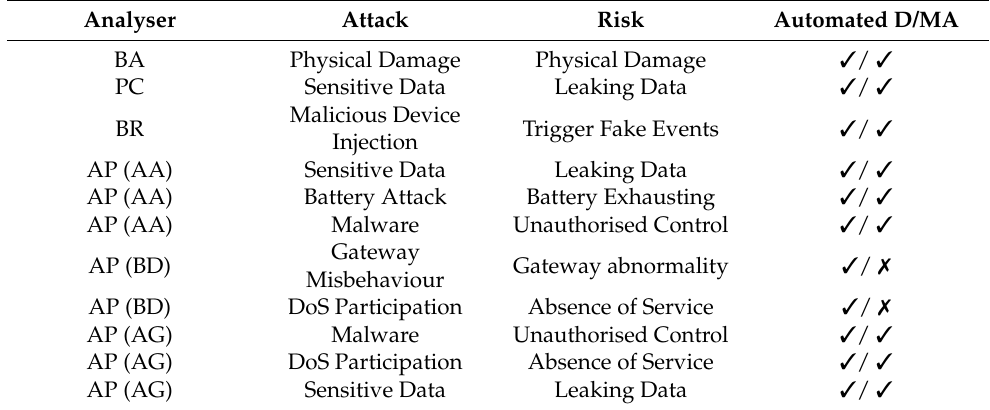
Table 9. Automation status of DRAF for decision making and